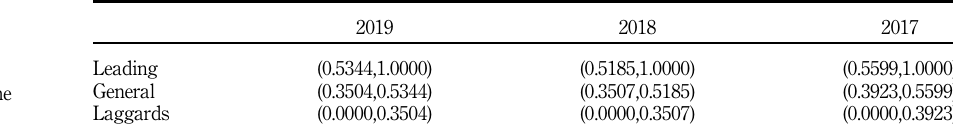
Table 8. Division of the three types